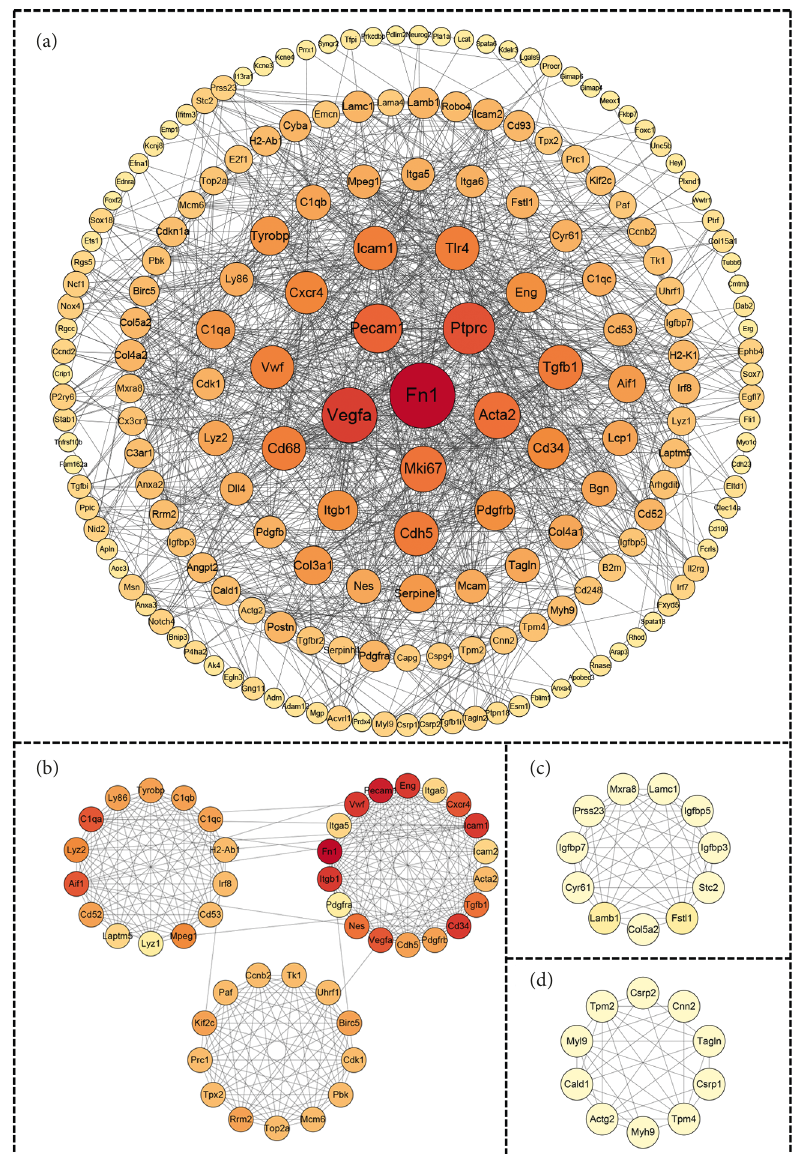
Figure 5: (a) PPI network of DEGs created by STRING. Circles represent genes, and lines represent PPIs. (b) The most significant module identified by MCODE (score � 13.773). (c) The second significant module identified by MCODE (score � 9.400). (d) The third significant module identified by MCODE (score � 7.556). DEG, differentially expressed gene; PPI, protein-protein